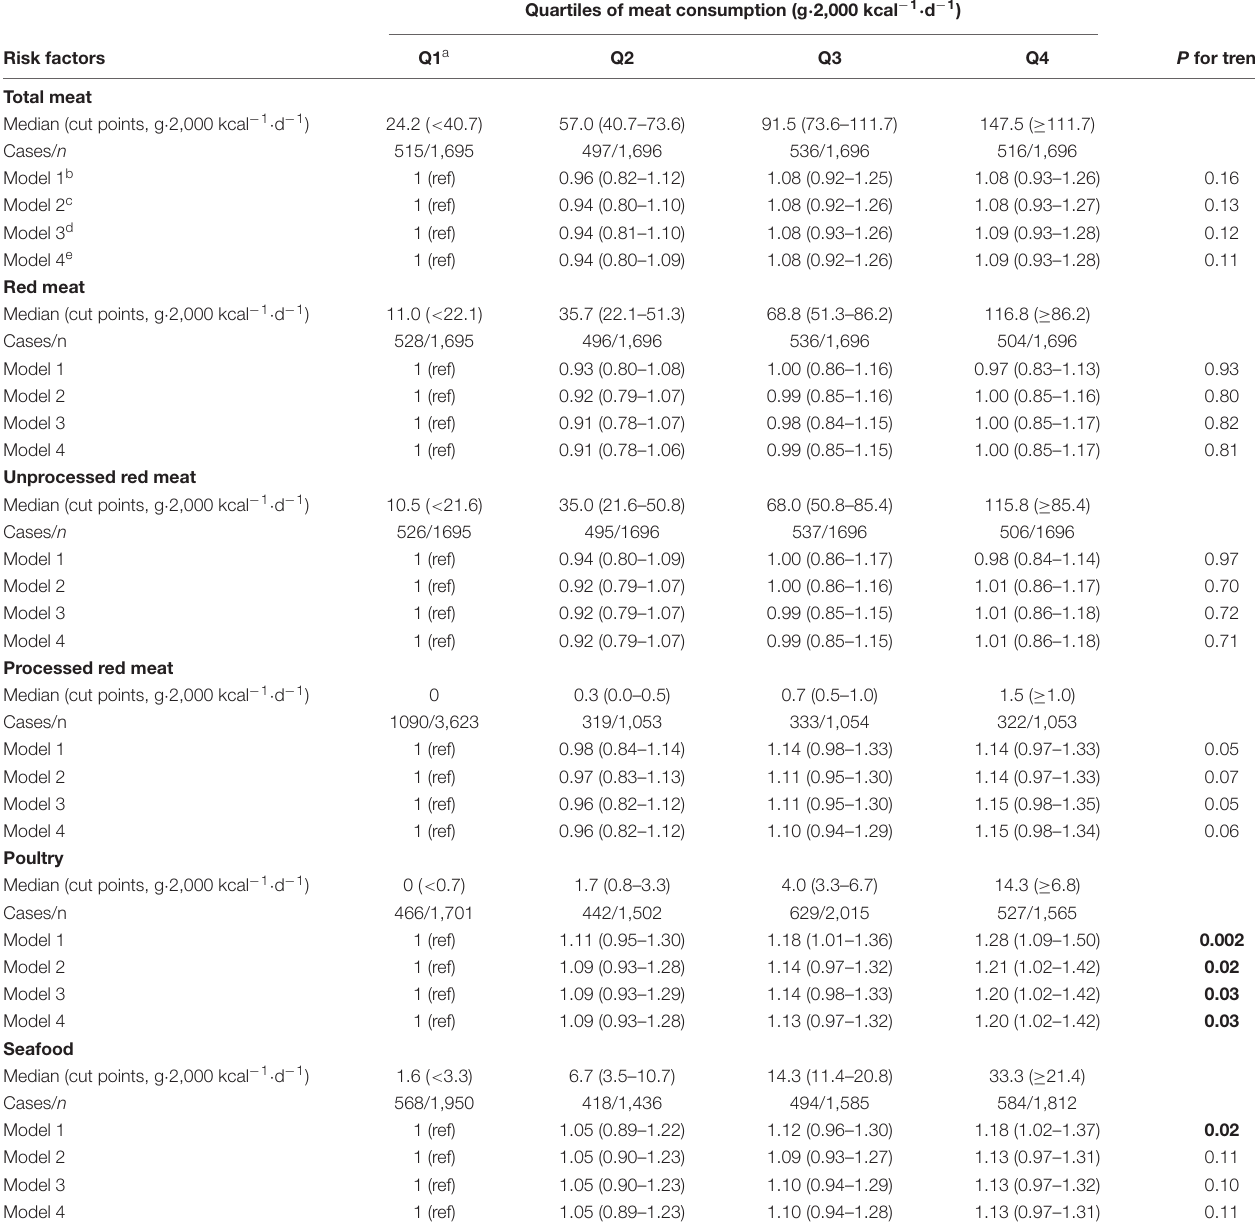
TABLE 2 | Multivariable-adjusted ORs (95% CIs) of meat consumption with the prevalence of colorectal